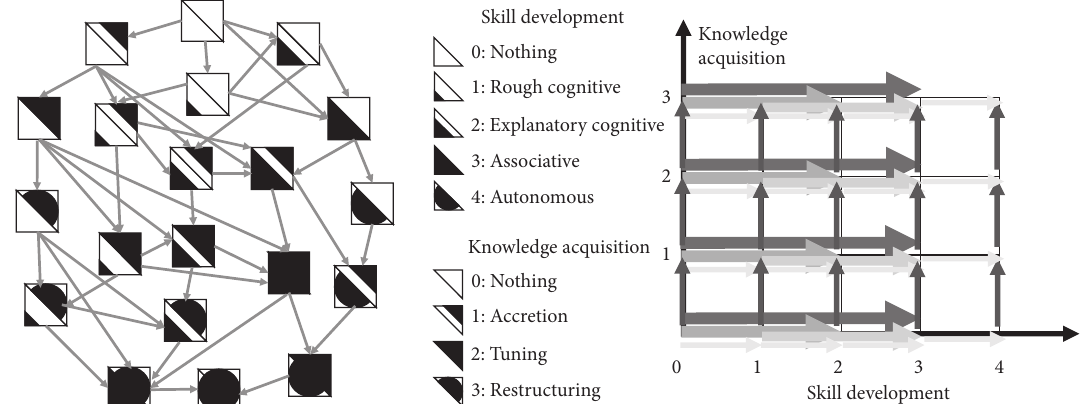
RestructuringKnowledge Acquisition Tuning3 Accretion2 Autonomous1